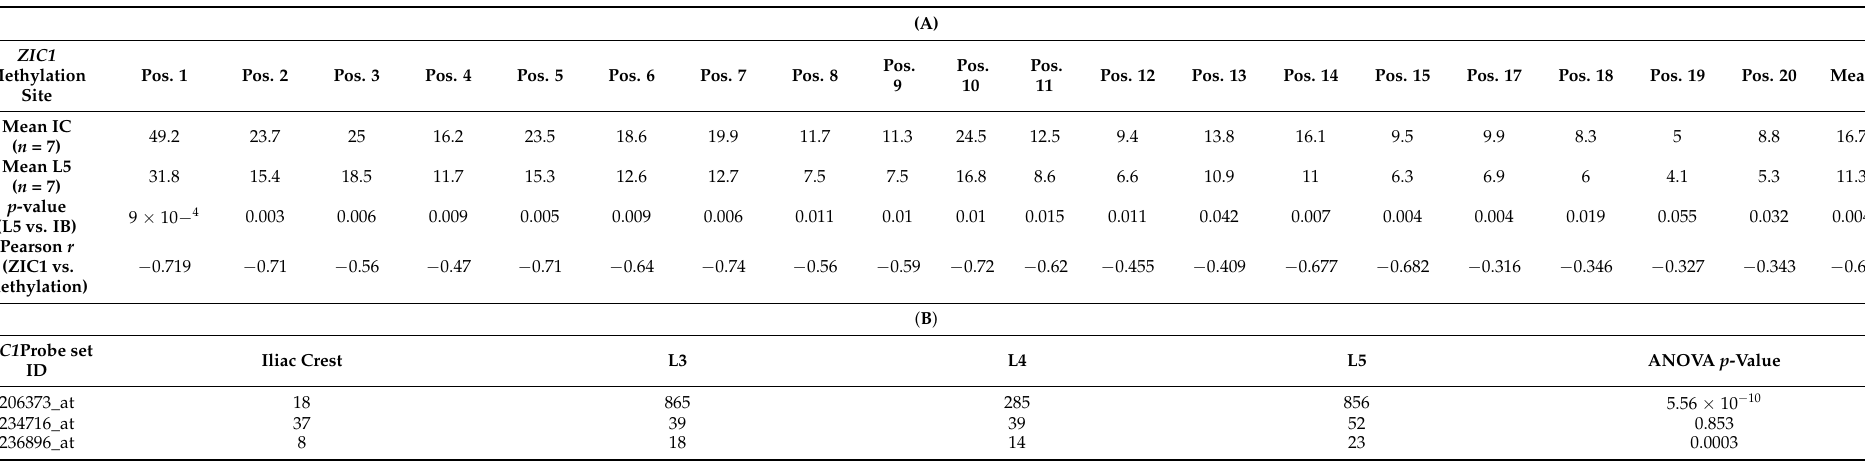
Table 1. ( A ) Comparison of ZIC1 promoter methylation in trabecular bone biopsies from male iliac crest (IB) and the lumbar spine (L5), as well as the correlation between the degree of ZIC1 promoter methylation at CpG positions and ZIC1 expression. ( B ) Differential expression of ZIC1 . The mean relative expression levels of ZIC1 mRNA in the lumbar spine vertebrae and iliac crest trabecular bone from